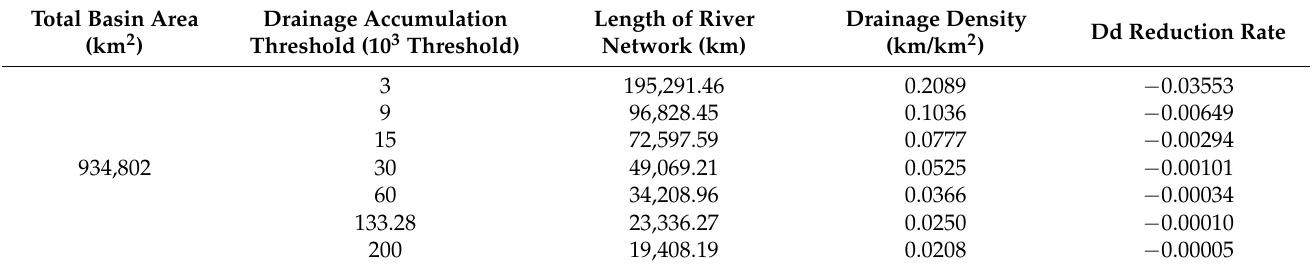
Table 2. Relationship between drainage density and drainage accumulation thresholds in the SRB. Total Basin Area (km 2